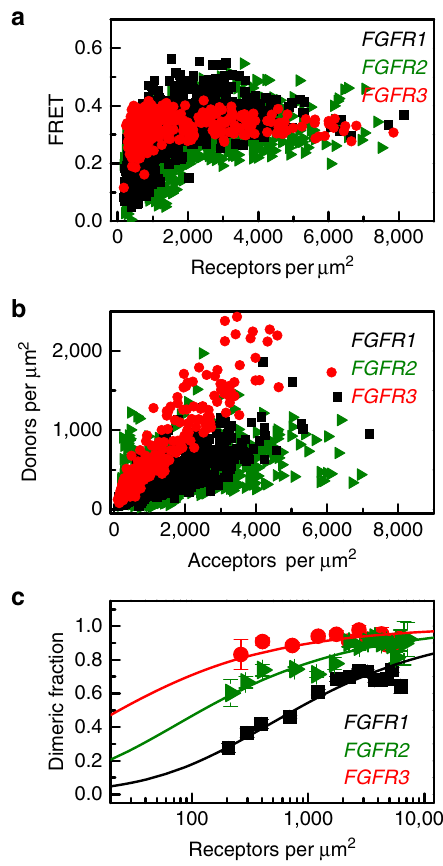
Figure 1 | FGF receptor dimerization in the absence of ligand. ( a ) Measured FRET in plasma membrane-derived vesicles, as a function of receptor concentration, for FGFR1 (black), FGFR2 (olive) and FGFR3 (red). Every data point represents a single vesicle. ( b ) The donor concentration is plotted as a function of the acceptor concentration, for each vesicle. ( c ) Dimeric fraction as a function of total receptor concentrations. The experimentally determined dimeric fractions are binned and are shown with the symbols, along with the standard errors. Each bin contains between 5 and 50 experimental points. The solid lines are the dimerization curves, plotted for the optimized dimerization parameters in Table